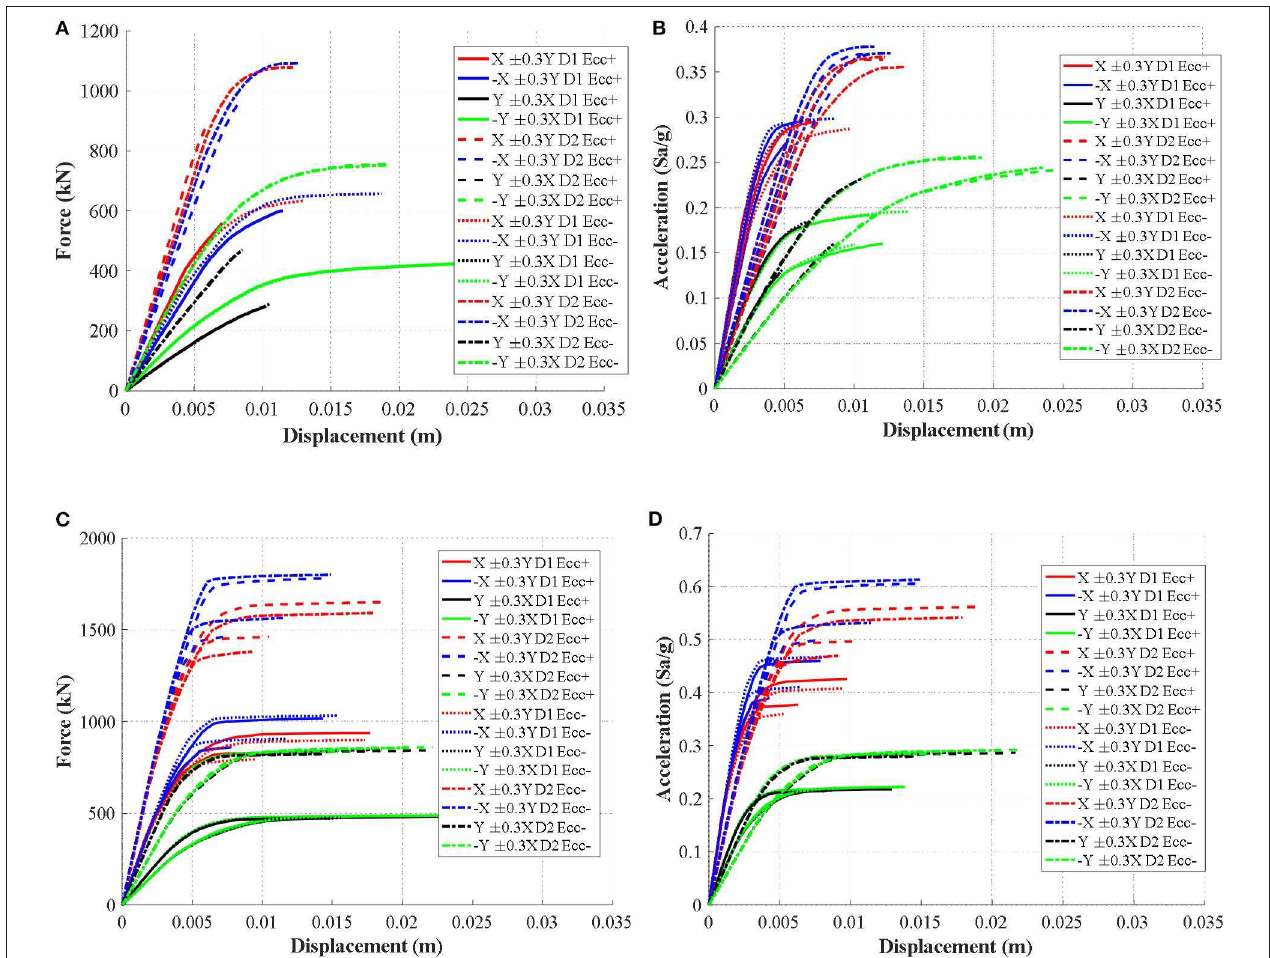
FIGURE 4 | Pushover curves before upgrading operations in terms of (A) base shear/displacement and (B) acceleration/displacement. Pushover curves after upgrading operations in terms of (C) base shear/displacement and (D)